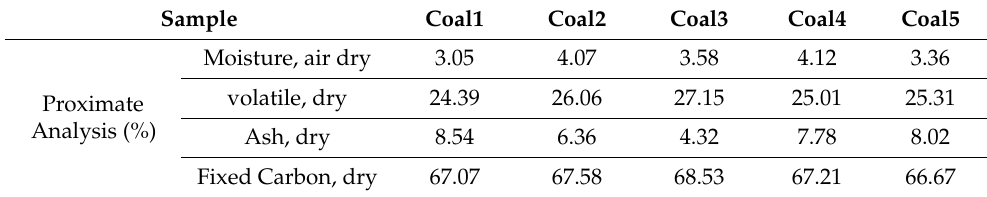
Table 1. Proximate analysis of five bituminous coal